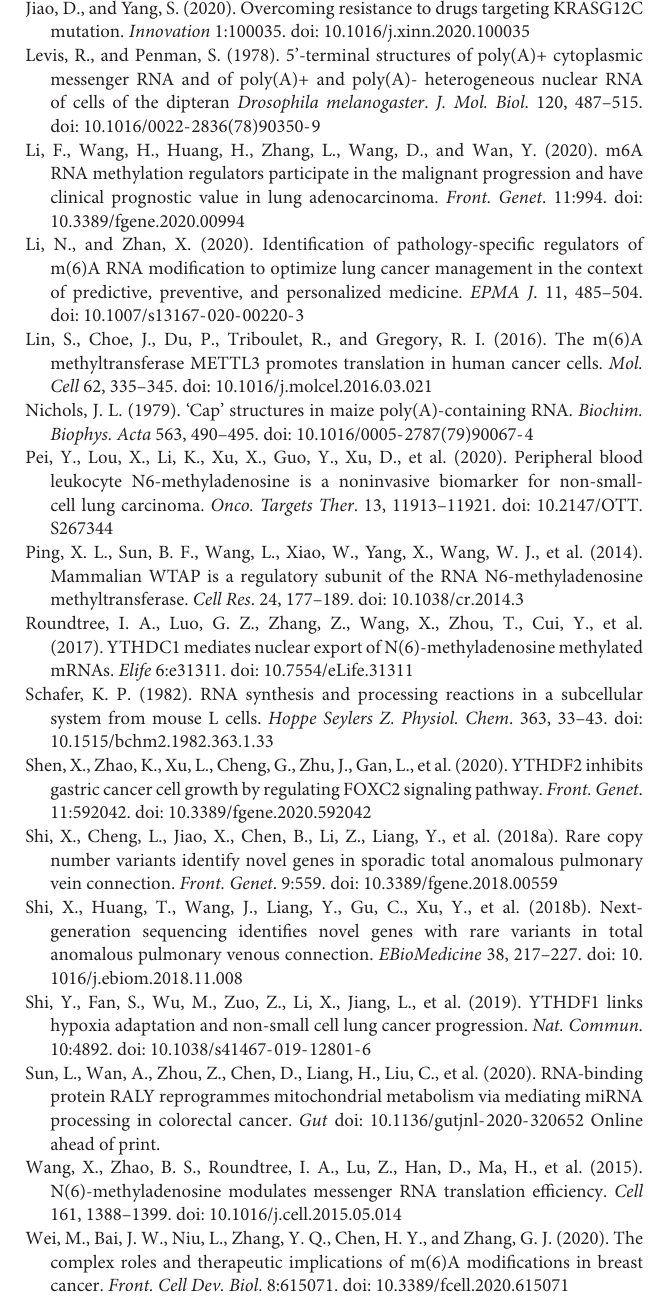
Supplementary Figure 1 | Representative immunohistochemical images for WTAP and YTHDC1. Supplementary Figure 2 | PPI network for WTAP, YTHDC1, and YTHDF1. Supplementary Figure 3 | The box plot for YTHDF1 in LUSC patients. Supplementary Figure 4 | The stage plot for YTHDF1 in LUSC patients. Supplementary Table 1 | Baseline characteristics of the LUSC patients in TCGA